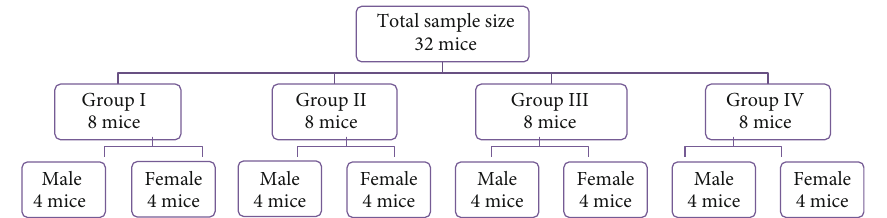
Figure 1: Random allocation of Swiss Albino mice into groups for the experiment. Table 1: Serum level of ALT and AST enzymes of the groups of the male and female mice.